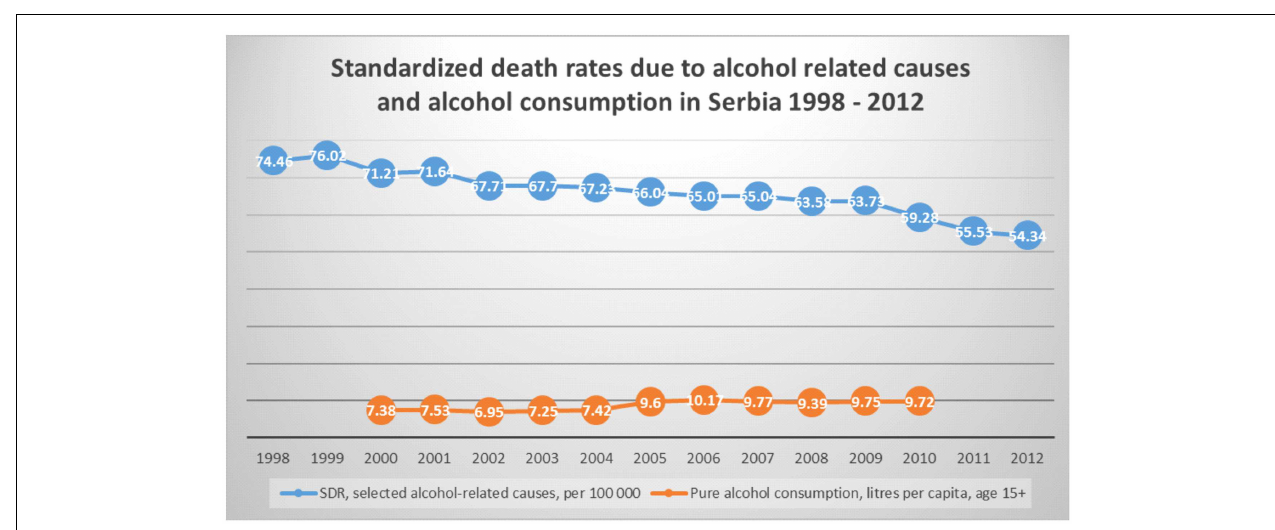
FIGURE 1 | Standardized death rates and alcohol consumption in Serbia 1998–2012 . *Source of data – European Health for All Database (HFA-DB) (31).